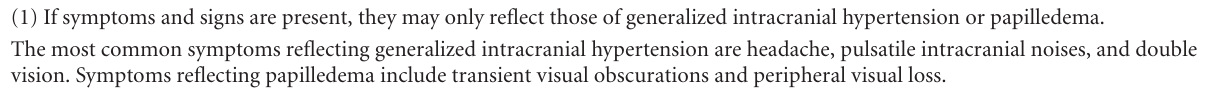
Table 1: Modified Dandy criteria for diagnosis of pseudotumor cerebri [16].